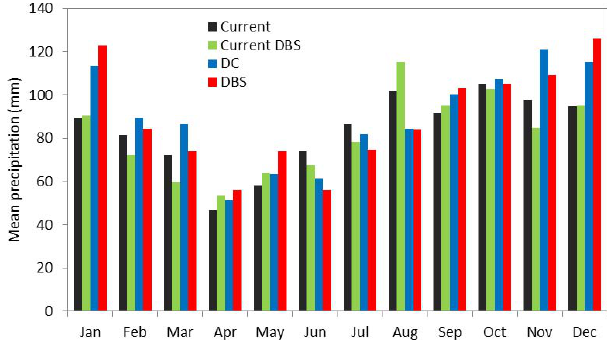
Table 1. Soil type (ST) parameters.